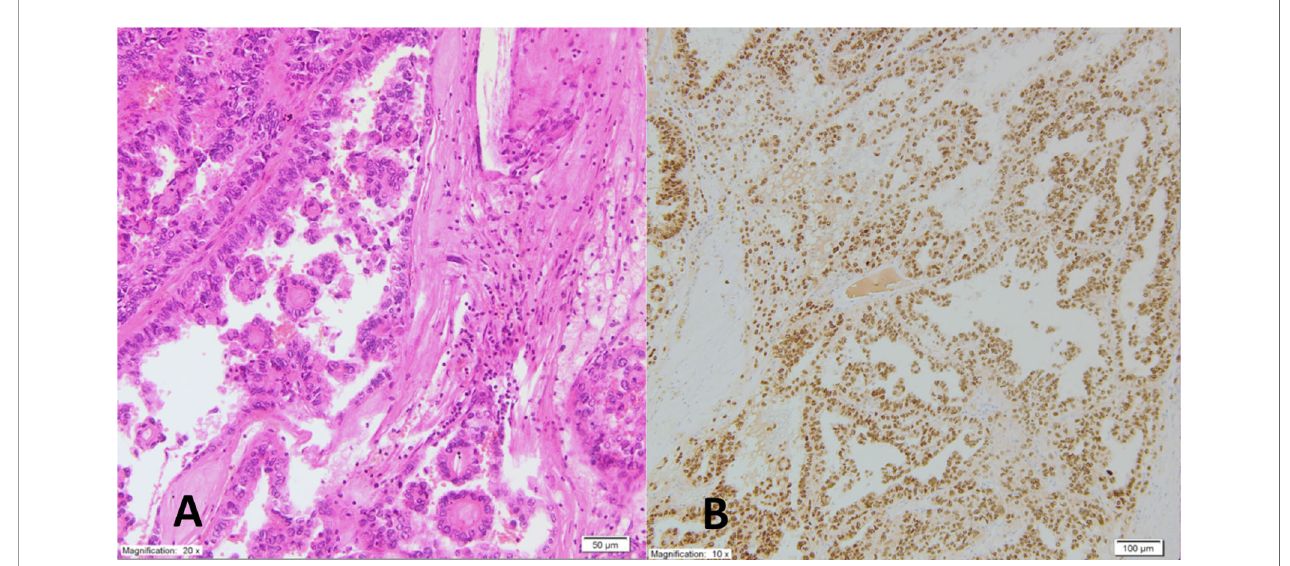
FIGURE 1 | Pathomorphologic picture of the tumor shows (A) . on HE examination epithelioid clear cancer cells with nuclear atypia forming papillary and tubular structures; (B) on IHC evaluation positive TFE3+